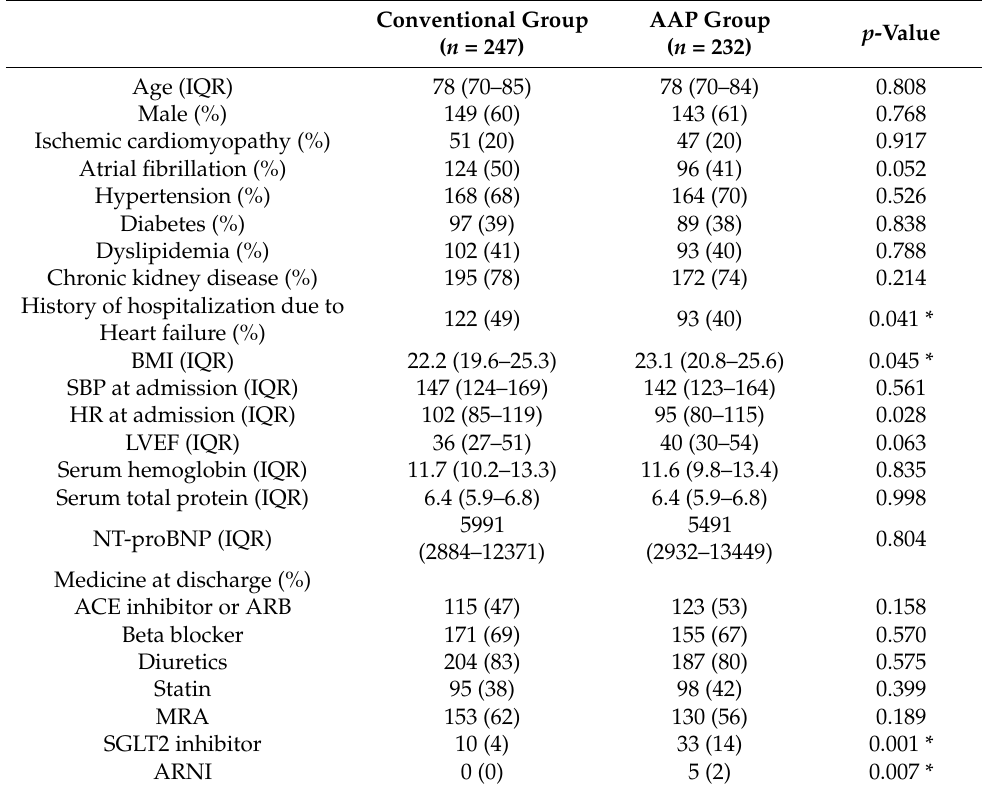
Table 1. Patient characteristics.